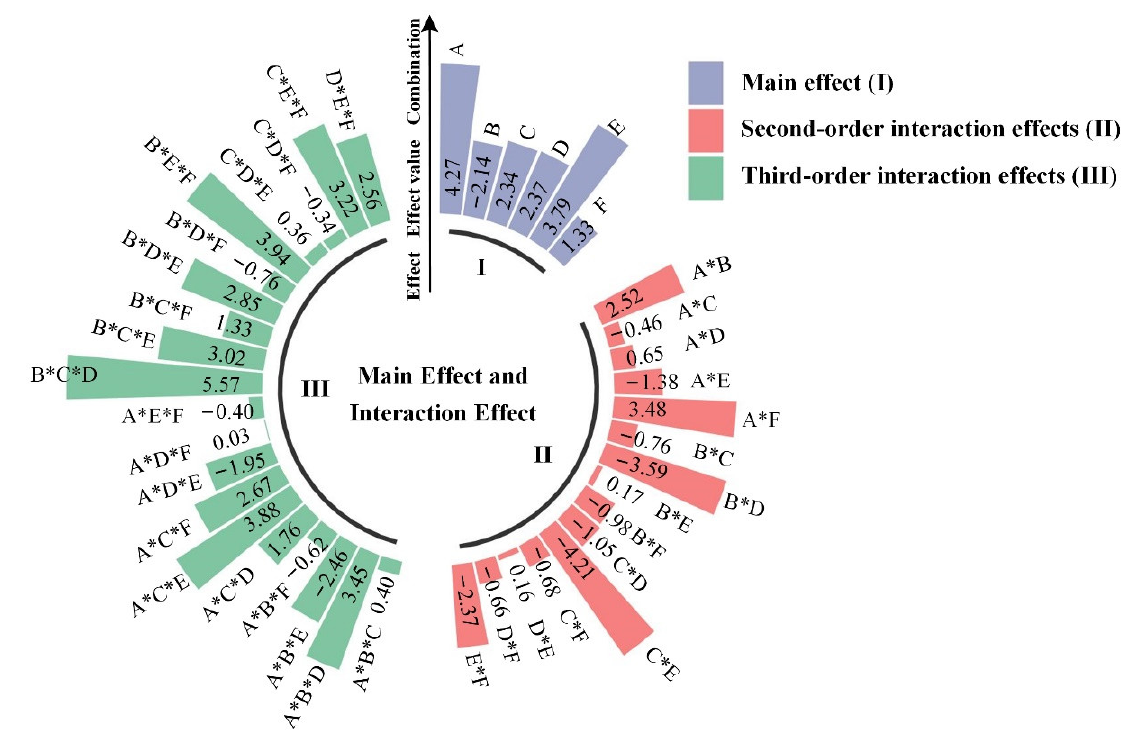
Figure 1. Main effects, second order and third-order interaction effects of polystyrene 5- polymer and degradation protein 7CC4 in the coexistence of plastic additives. (* Implies simultaneous use of multiple components). Table 6. The major effects of plastic additives on the total contribution rate of plastic biodegradability, as well as their interactions.